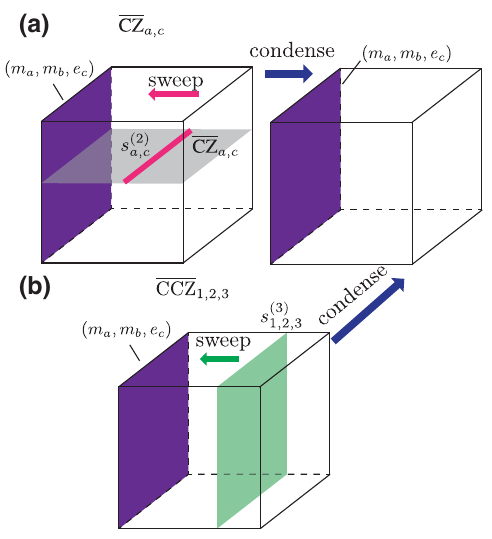
FIG. 27. The existence of transversal logical CZ and CCZ gates in a stack of three 3D surface codes is ensured by the conden- sation of their corresponding domain walls S ( 2 ) boundary ( m a , m b , e c )